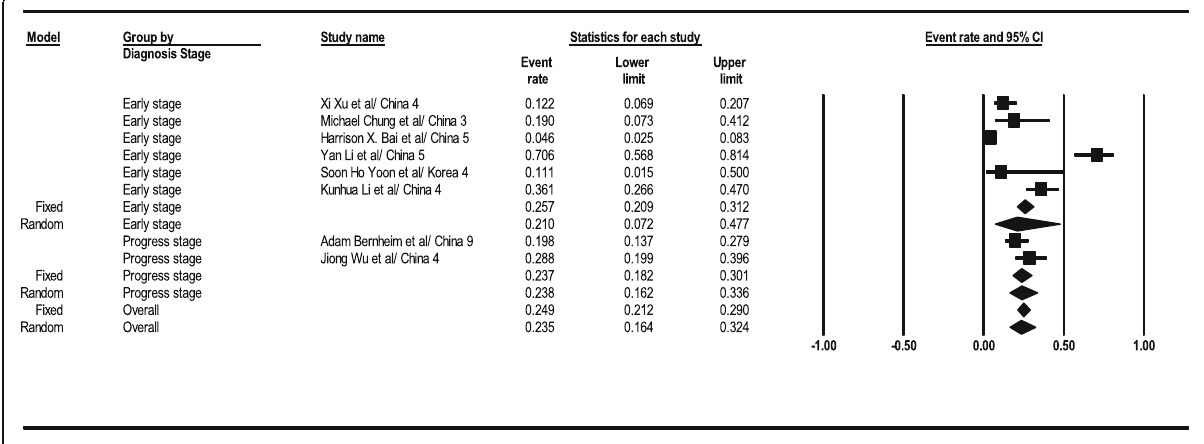
Fig. 5 Results of GGO in CT scan of